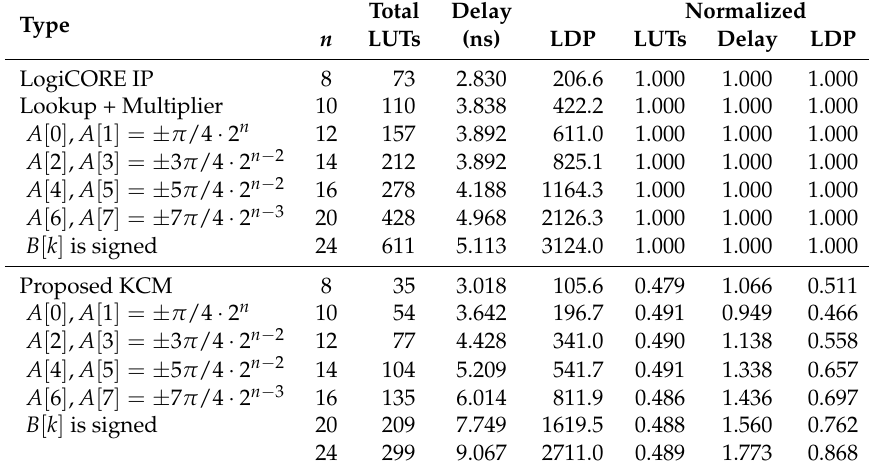
Table 11. Synthesis results for single-cycle ( m × n )-bit KCMs with eight selectable coefficients where